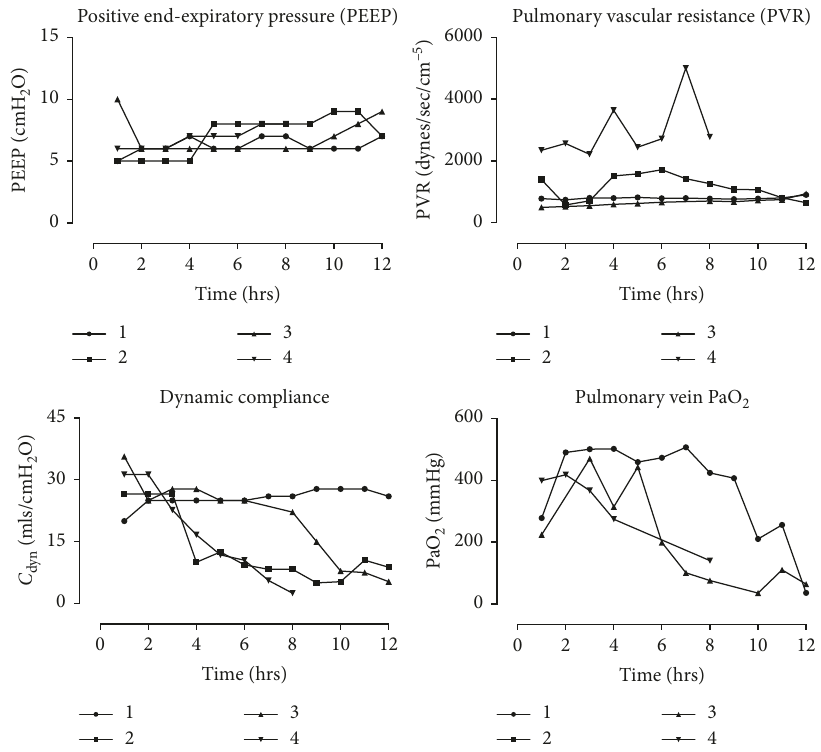
Figure 5: Porcine EVLP and ventilation parameters first recorded at 1hr after the initiation of perfusion. Pulmonary vein sampling of PaO was collected from blood leaving the left atrial remnant with FiO 2